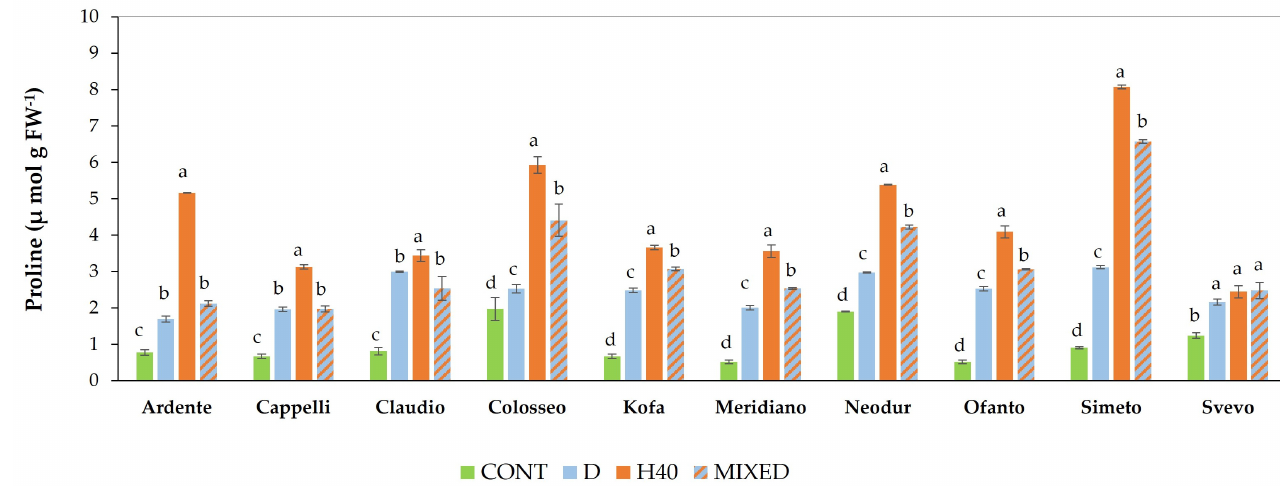
Figure 4. Free proline content measured in ten T. durum cvs in control conditions (CONT, green bar) and in response to drought stress (D, blue bar), to heat shock (H40, red bar), to mixed stress (MIXED, blue-red bar). The results are shown as the mean and standard deviation of the three replicates, expressed in μ mol g FW − 1 . For each cv, columns marked with different letters indicate significant difference among treatments at p < 0.05 (ANOVA with post-hoc Bonferroni-Holm test). In response to D, Simeto and Claudio showed the highest amount of proline (3.12 and